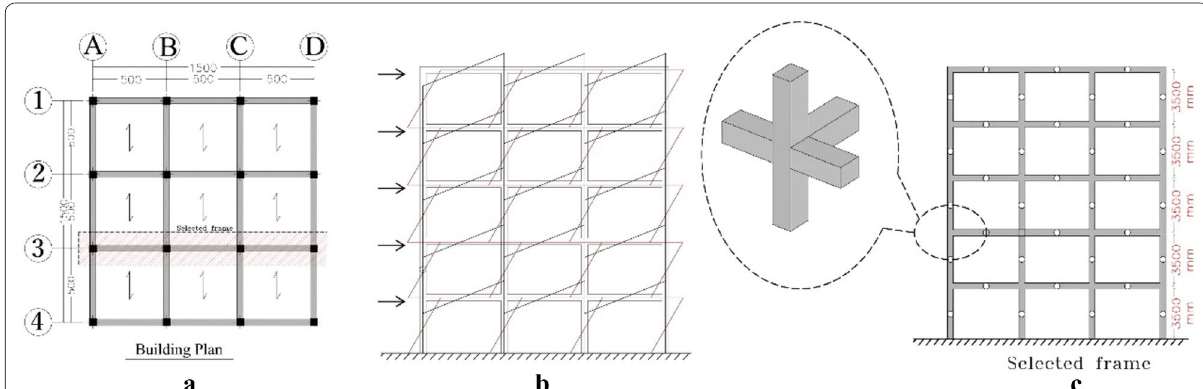
Fig. 7 Beam-column joint extracted from the existing five-storey RC building. a Building plan, b moment diagram under earthquake load; c details of building a frame and the isolated exterior beam-column joint used for the experimental study.